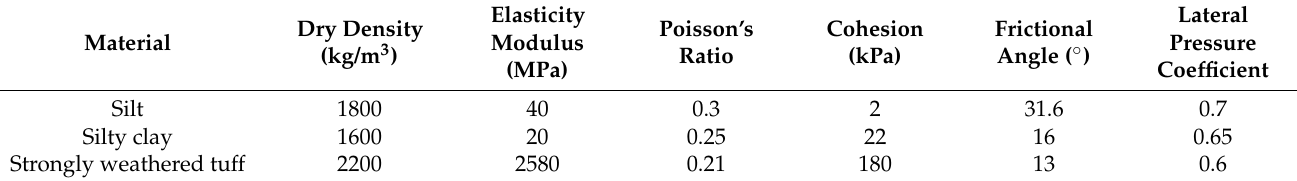
Table 2. Formation parameters.